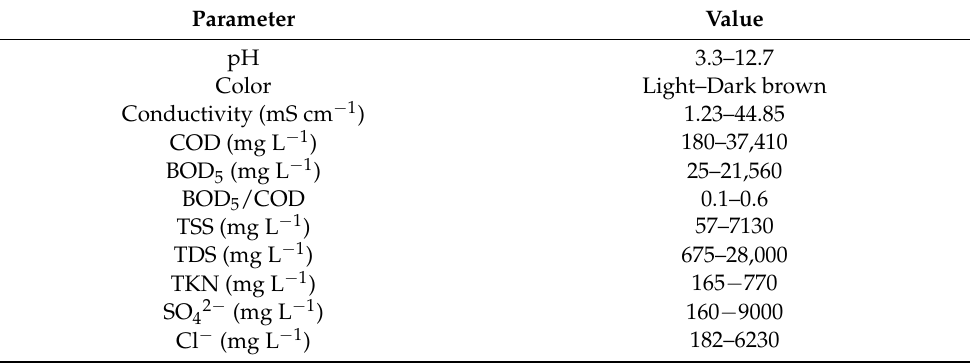
Table 1. Composition of pharmaceutical industry wastewater